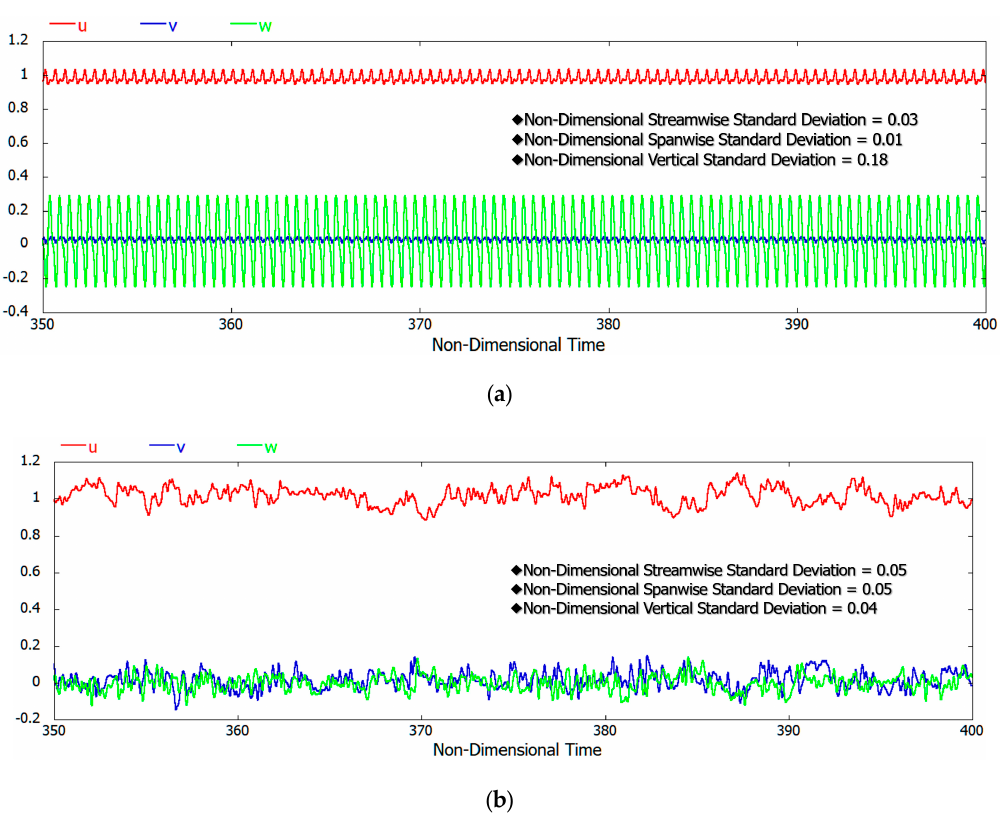
Figure 15. Time variation of three velocity components at N = 4 measurement points shown in Figure 14a: ( a ) x = 0.5 D and z = 0.5 D; ( b ) x = 30.0 D and z = 0.5 D.